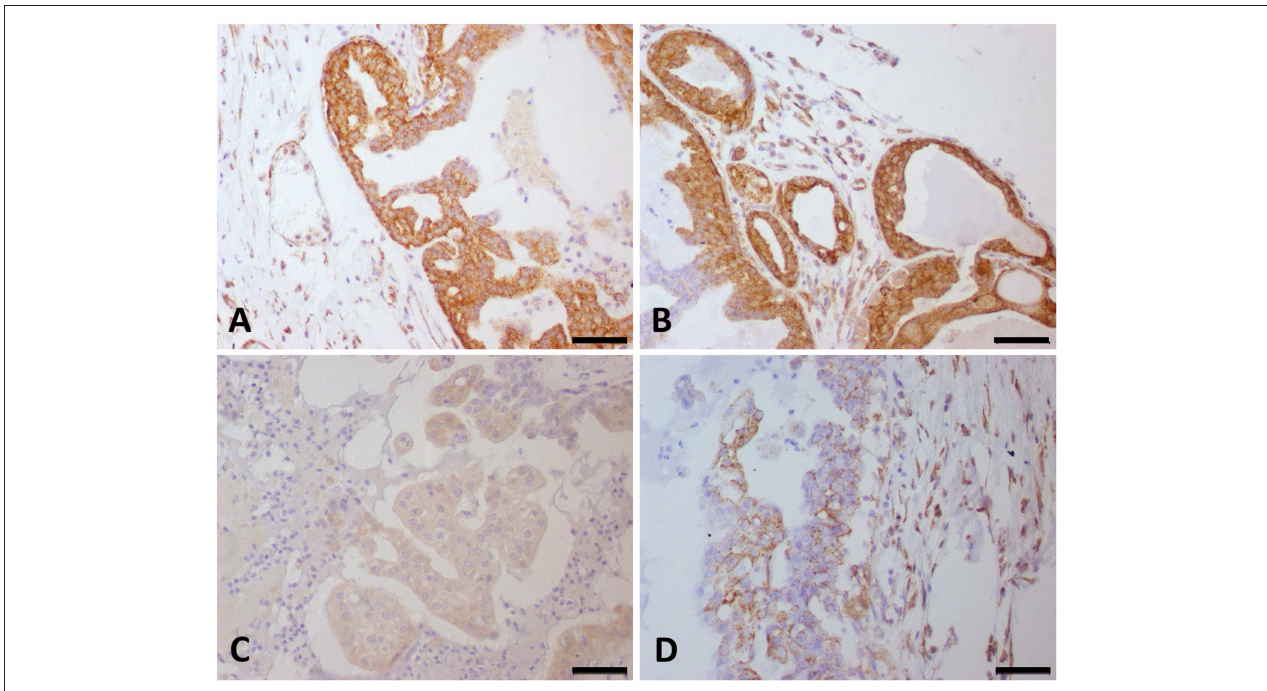
FIGURE 3 | VEGF-A and VEGFR-2 expression in canine mammary gland tumor samples. Strong (score 4) VEGF-A (A) and VEGFR-2 (B) expression was observed in the same tumor samples. (C) Canine mammary gland tumor showing a score of 1 for VEGF-A expression. (D) Canine mammary gland tumor showing a score of 2 for VEGFR-2